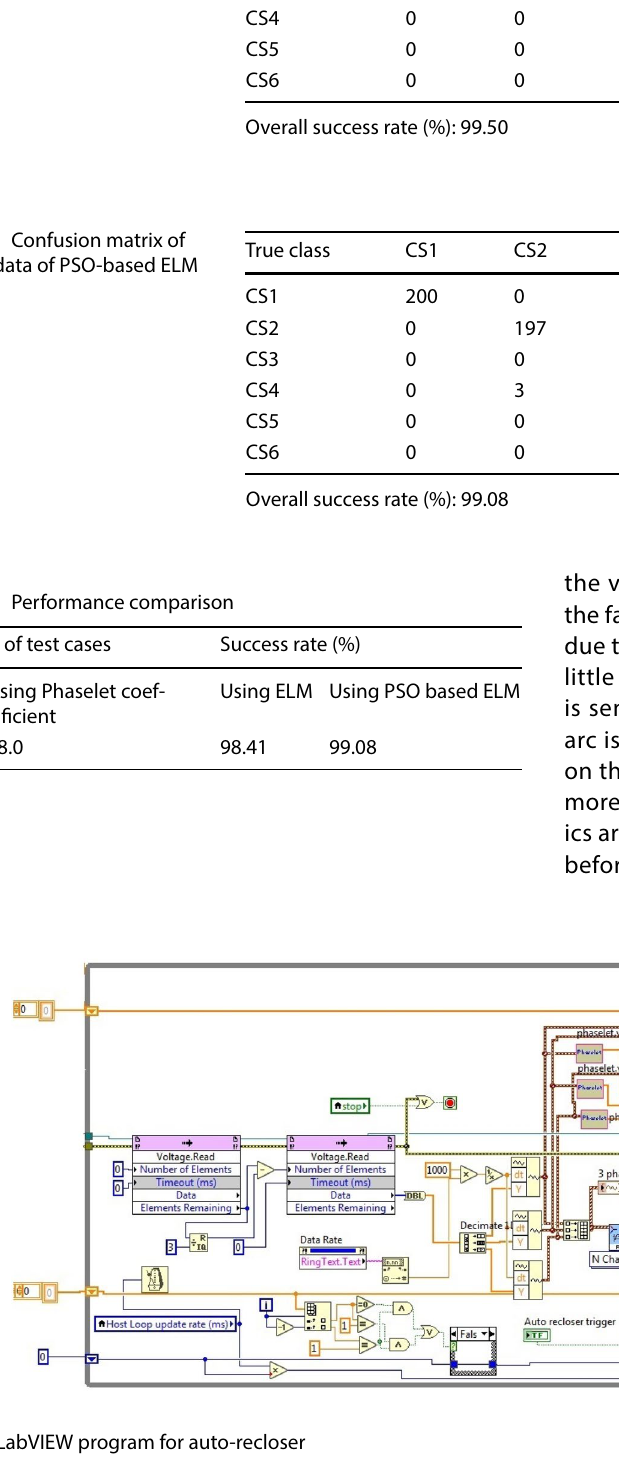
Table 11 Confusion matrix of training data of PSO-based ELM